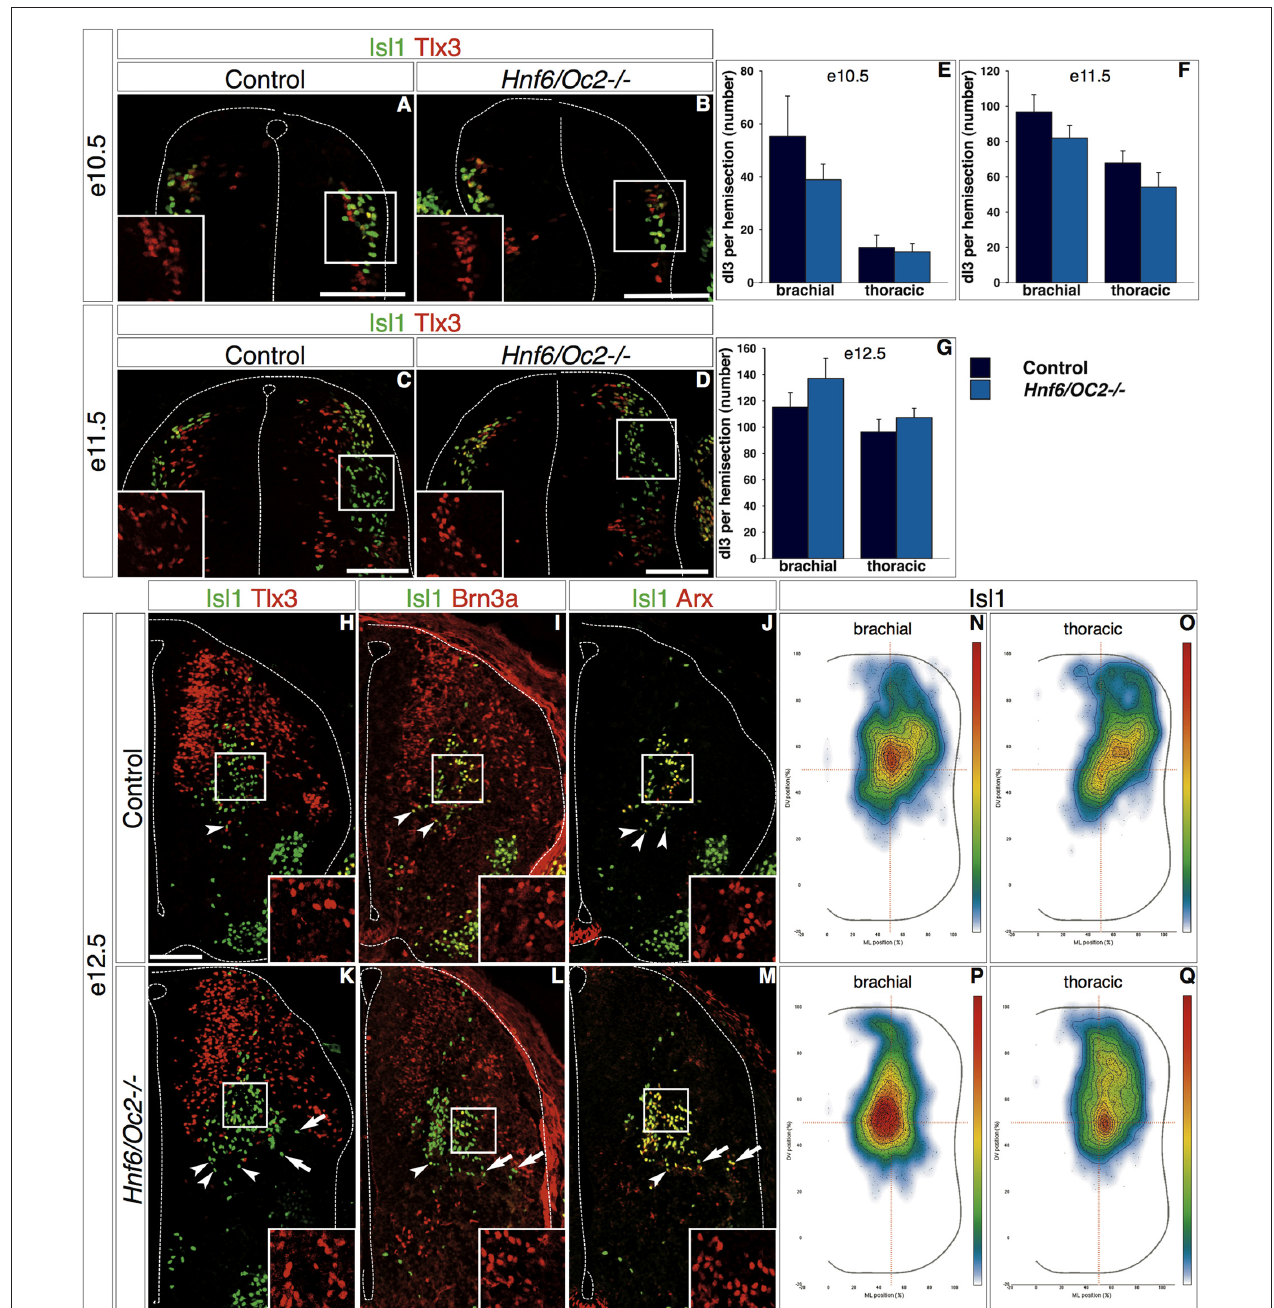
FIGURE 4 | OC factors control dI3 distribution. (A–M) Differentiation and distribution of dI3 interneurons in control or Hnf6/Oc2-/- embryos. At e10.5 (A,B) and e11.5 (C,D) , dI3 interneurons containing Isl1 and Tlx3 in Hnf6/Oc2-/- embryos (B,D) are detected in numbers and distributions comparable to those observed in control embryos (A,C) . Tlx3+Isl1- cells next to the ventricular zone in e11.5 control embryo are late-born dILB (C) . (E–F) Quantitative analysis of control or Hnf6/Oc2-/- embryos at e10.5 ( E , n = 4) and e11.5 ( F , n = 4) shows no statistically significant difference in the number of dI3 cells. At e12.5, Isl1 combined with Tlx3, Brn3a or Arx identifies dI3 interneurons in the central intermediate spinal cord of control (H–J) or Hnf6/Oc2-/- (K–M) embryos. The number of dI3 cells is comparable in control and mutant embryos, and Tlx3, Brn3a and Arx are detected in the Isl1-positive cells (insets in H–M ) indicating that the differentiation of dI3 interneurons is not affected by the absence of Onecut factors. Quantitative analysis shows similar numbers of dI3 cells in control or mutants embryos ( G , control n = 6, mutant n = 7). However, the distribution of these cells seems different in Hnf6/Oc2-/- embryos (arrows). (N–Q) Density plots of dI3 interneuron distribution at brachial (N,P) or thoracic (O,Q) levels in control (N,O) or Hnf6/Oc2-/- mutant (P,Q) spinal cord at e12.5 show an alteration in the localization of dI3 cells in mutant embryos. The dI3 interneurons migrate as a more compact population in a general dorso-medial to ventro-medial direction, with the densely-packed cells closer to the